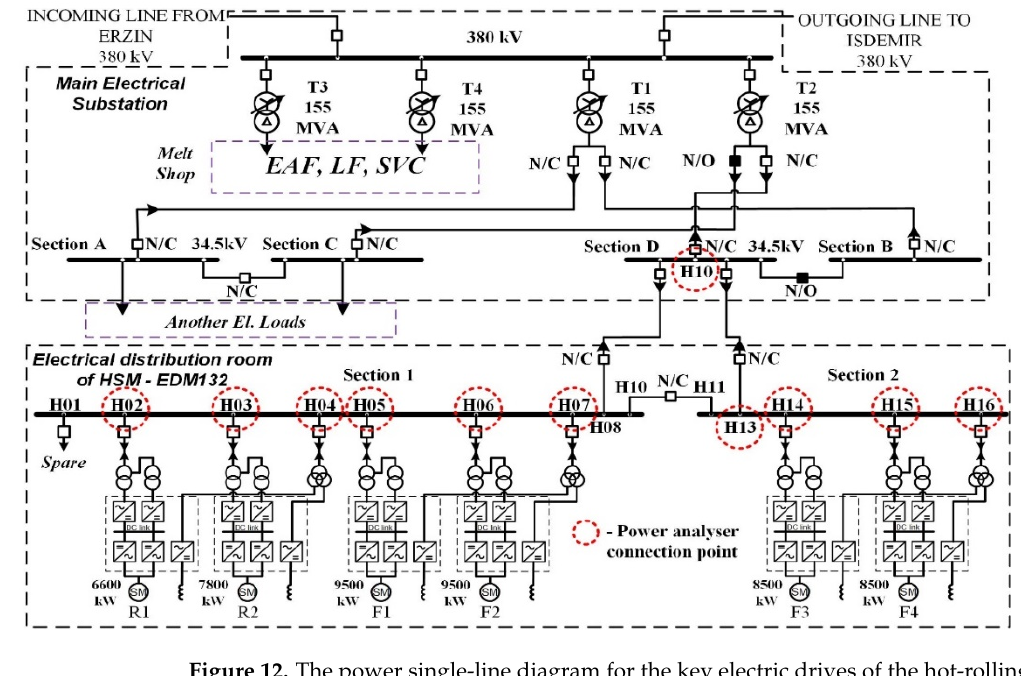
Figure 12. The power single-line diagram for the key electric drives of the hot-rolling mill.